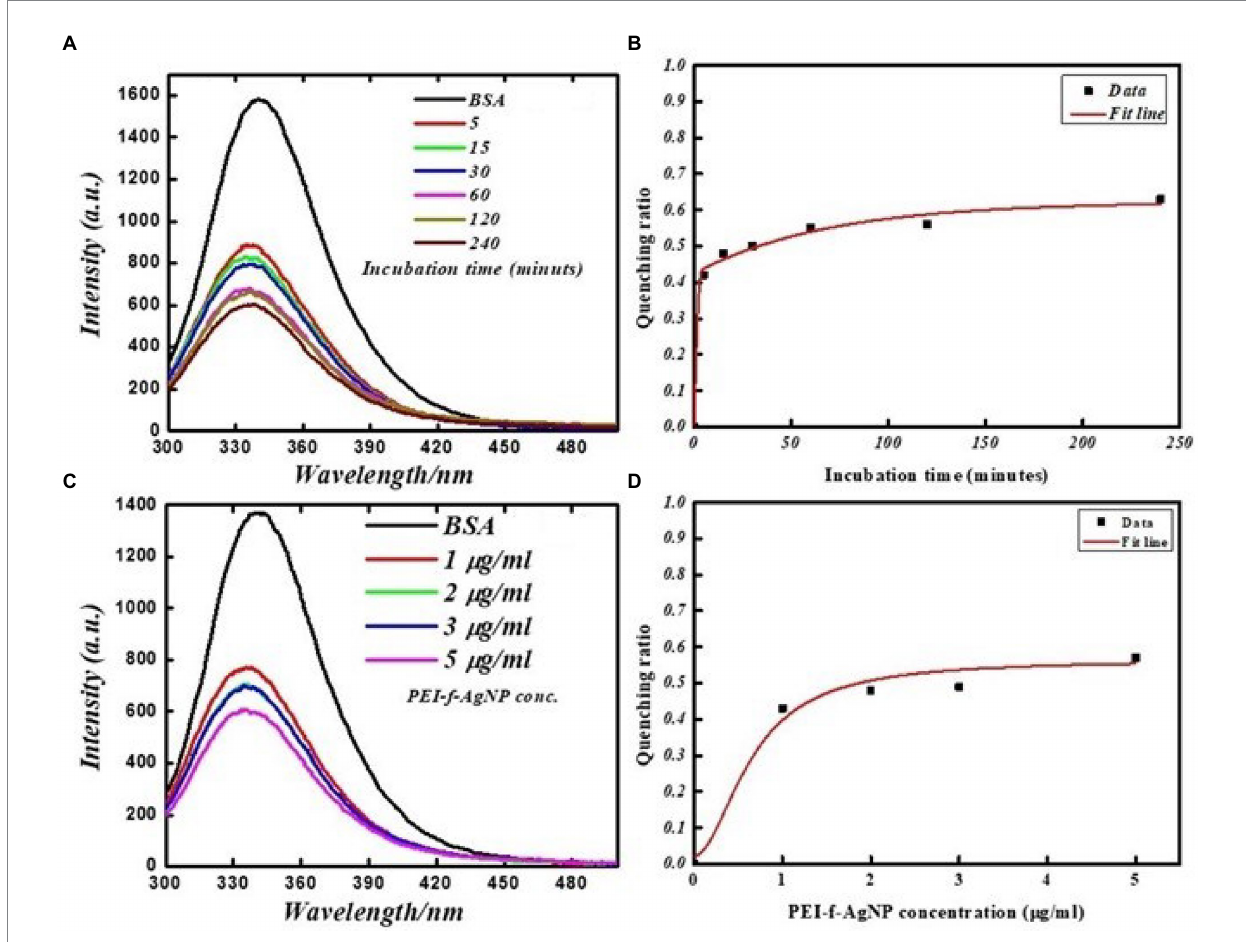
FIGURE 6 FL emission spectra of BSA protein at various times with and without PEI-f-Ag-NPs: (A) fluorescence emission spectrum at various incubation times, (B) FL quenching ratio at various incubation times, (C) FL emission spectra with increasing concentration of PEI-f-Ag-NPs, and (D) FL quenching ratio with increasing PEI-f-Ag-NPs